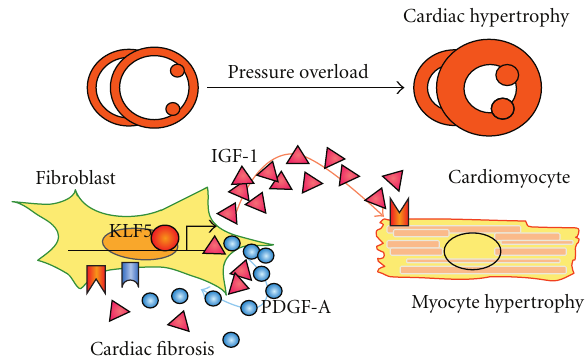
Figure 3: A model for the regulation of fibroblasts by KLF5 dur-ing cardiac hypertrophy. The transcription factor KLF5 controls Igf1 and Pdgfa expression in cardiac fibroblasts. IGF-1 is a major cardi- otrophic factor secreted from fibroblasts, and PDGF-A is primarily involved in mediating the migrationand proliferation of